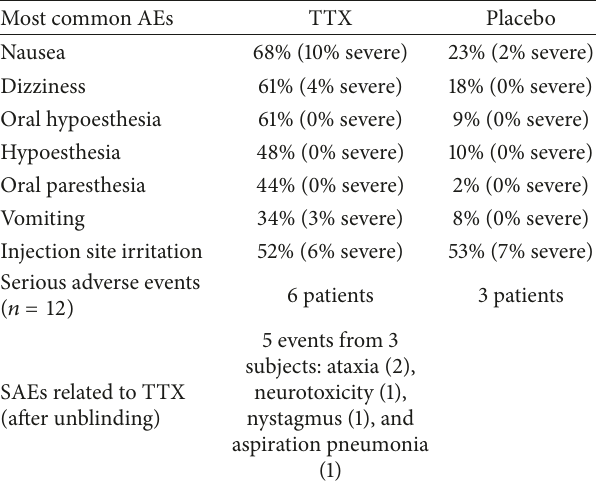
Table 2: Most common adverse